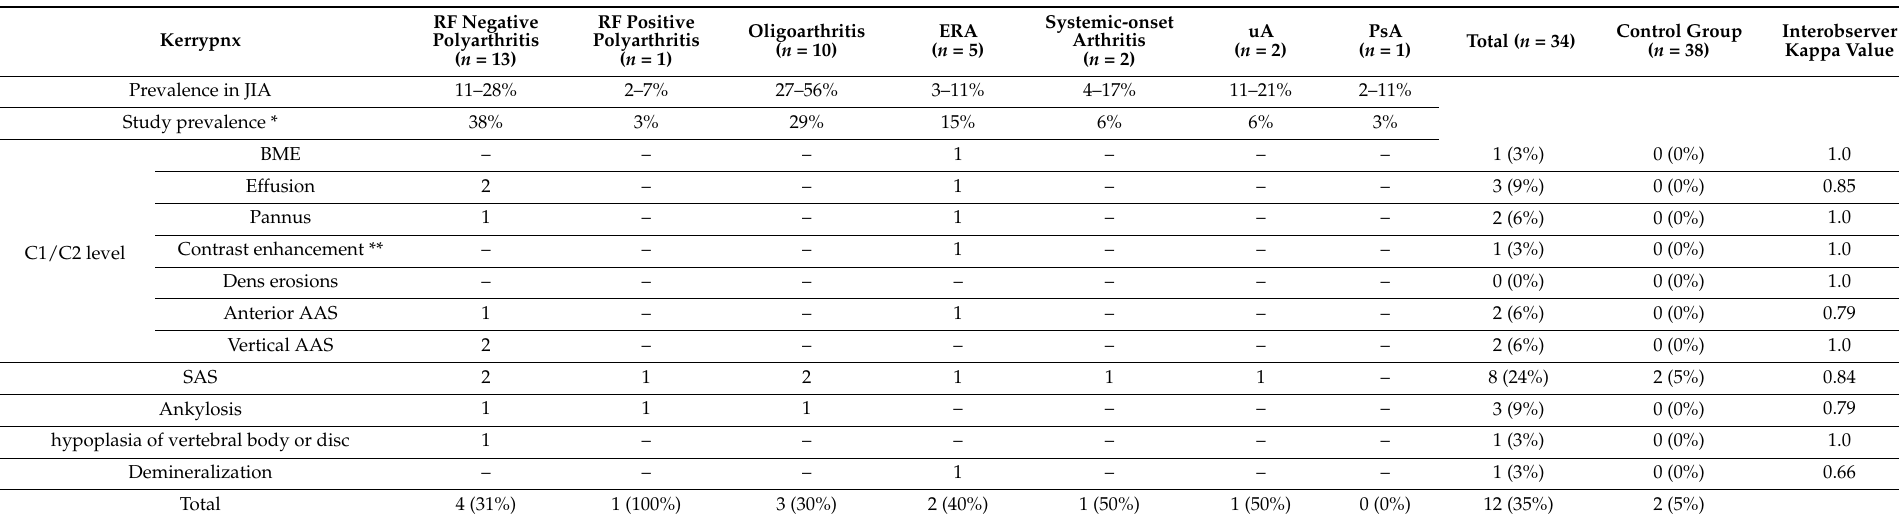
Table 2. Prevalence of different lesions in cervical spine in patients diagnosed with